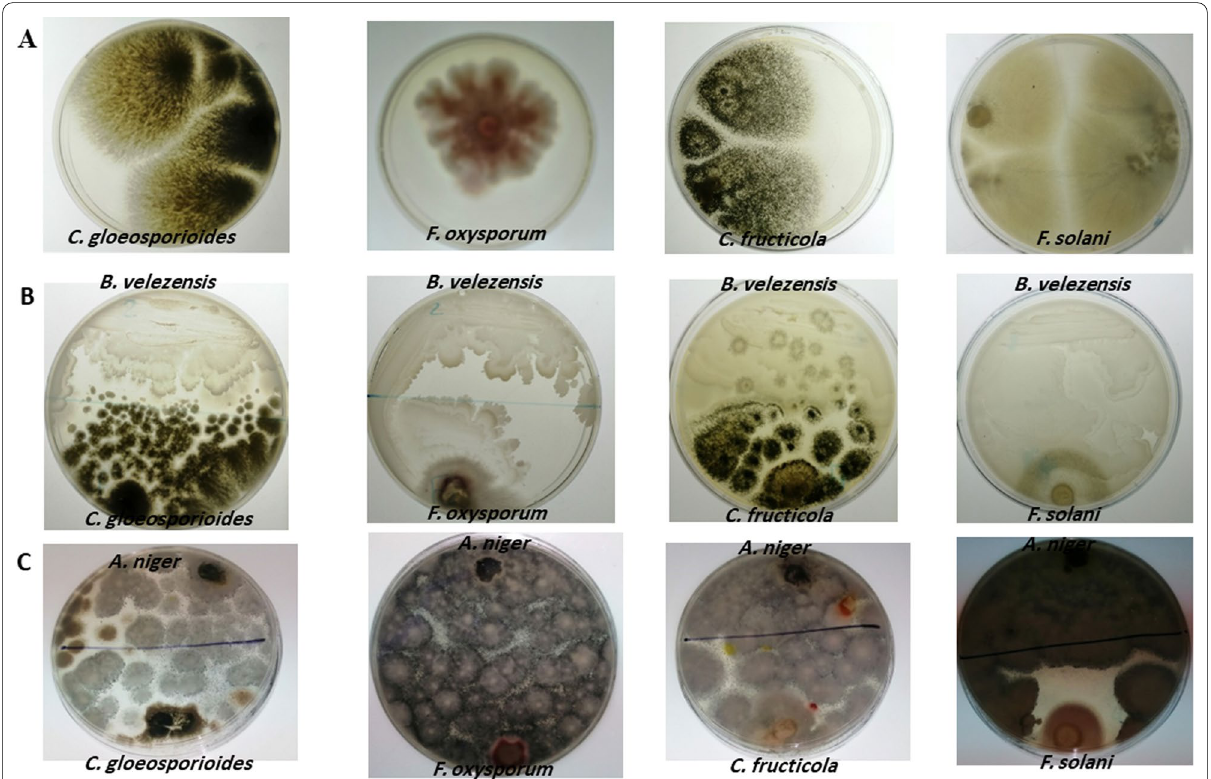
Fig. 2 Antimicrobial effect of Bacillus velezensis 33RB and Aspergillus niger 46SF against Colletotrichum gloeosporioides BJ02, Fusarium oxysporum 20RF , C. fructicola, and F. solani